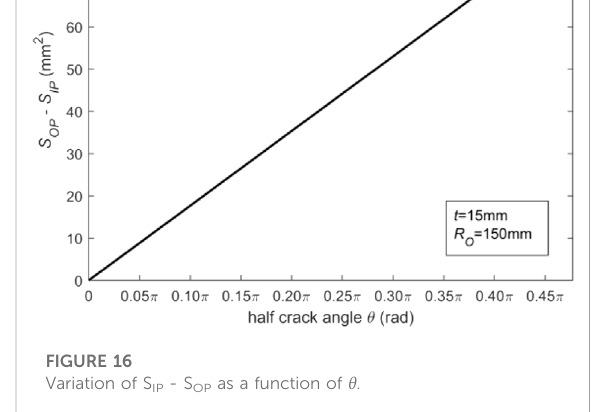
FIGURE 16 Variation of S IP - S OP as a function of θ .